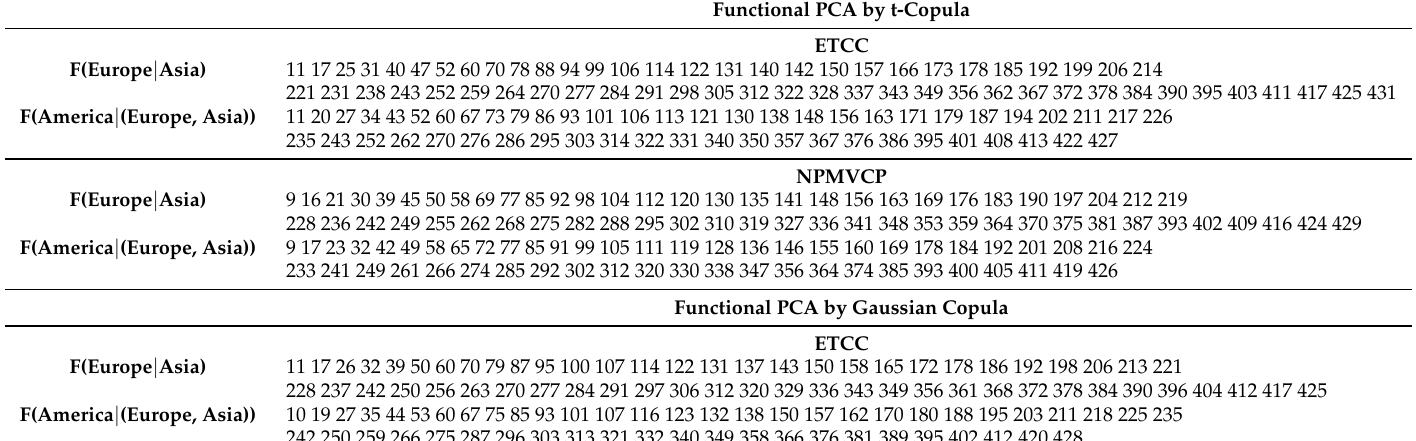
Functional PCA by t-Copula ETCC